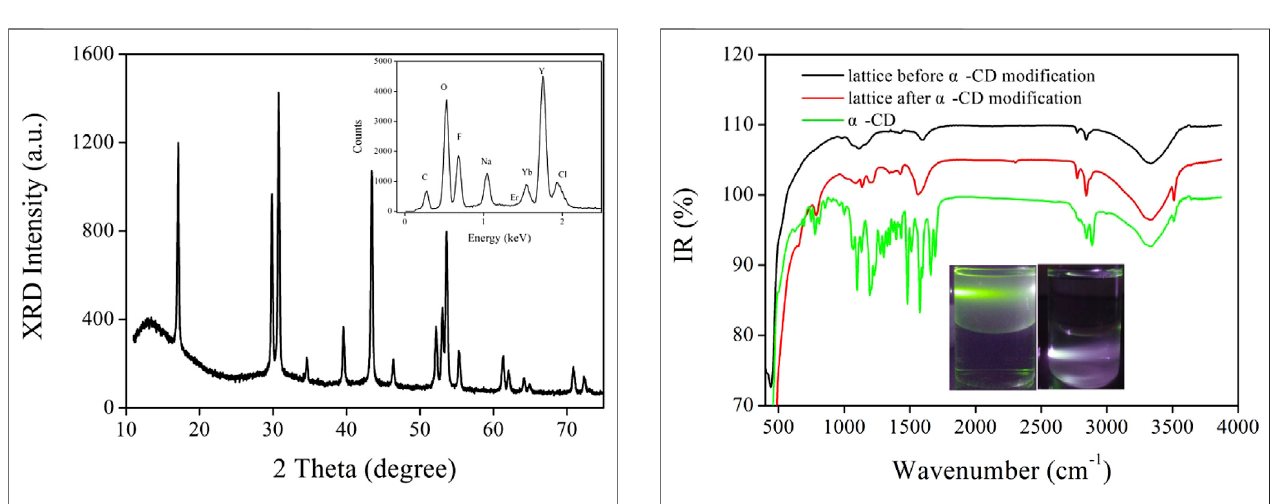
FIGURE 2| Wide angle XRD pattern ofour up-conversion NaYF 4 lattice. Inset: EDX spectrum of our up-conversion NaYF 4 lattice.